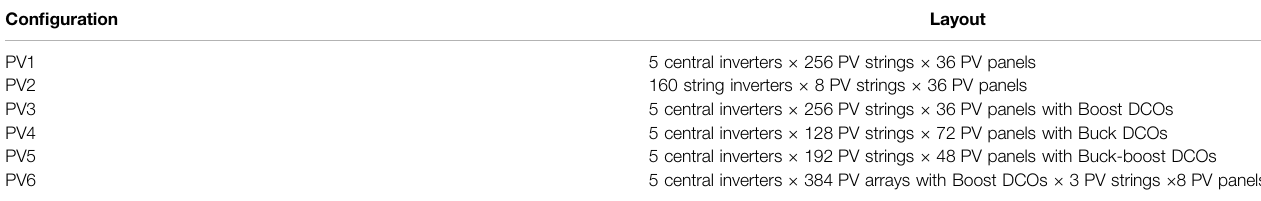
TABLE 2 | Layouts of the six PV plants. Con fi guration Layout